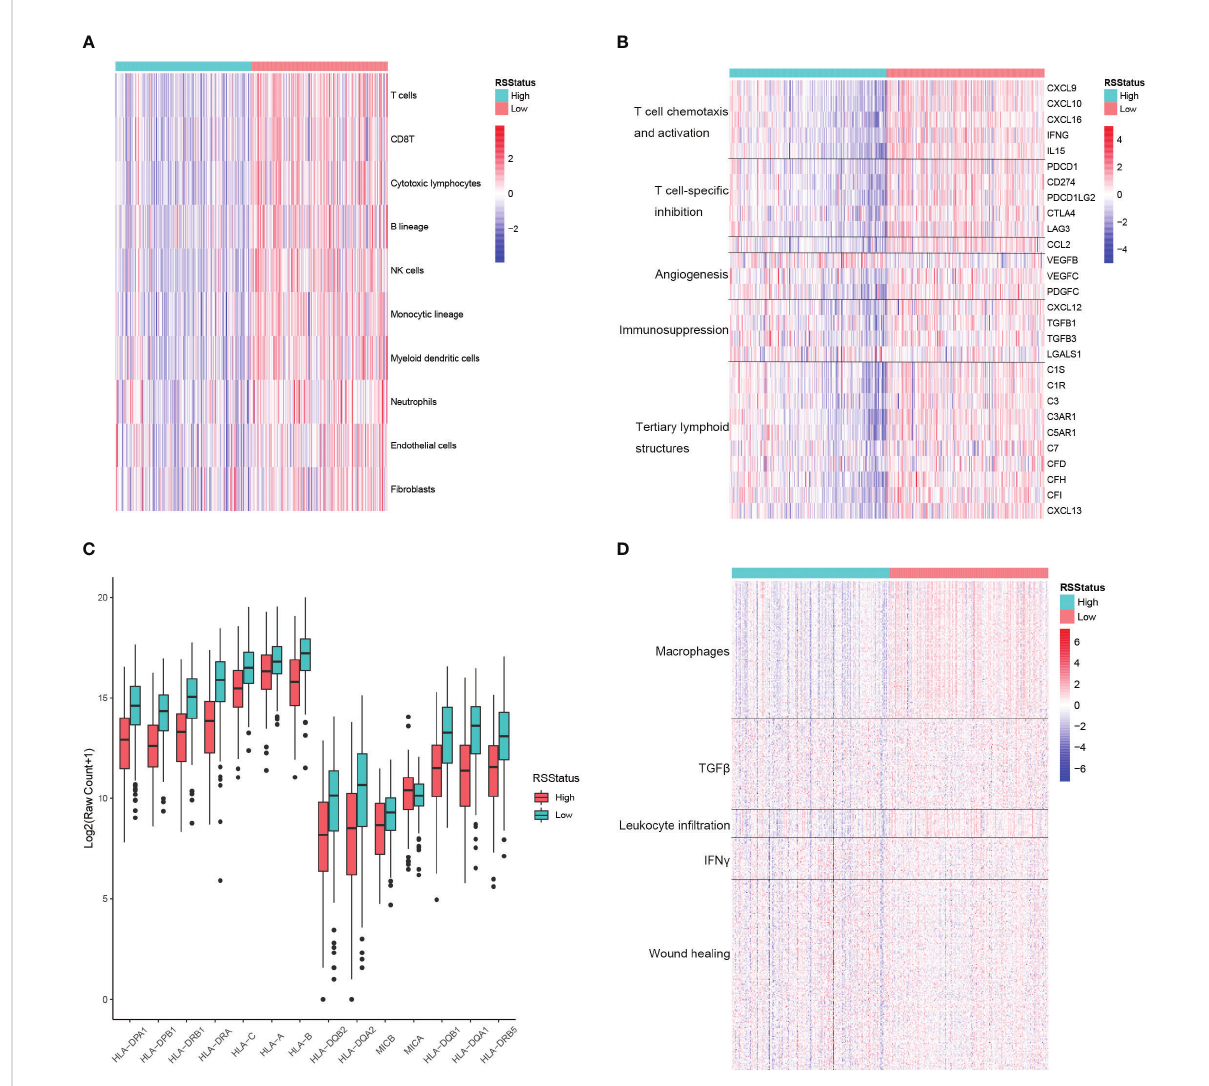
FIGURE 5 The signature based on the CEBPB-regulated genes in macrophages is closely associated with immune activity in metastatic SKCM TME. (A) Relative abundance of lymphocytes, myeloid cells, and stromal cells in metastatic SKCM patients ’ tumor samples of the TCGA-SKCM cohort strati fi ed by the median RS value. (B) Relative expression of genes of several immunologically suppressive and active signatures in metastatic SKCM patients ’ tumor samples of the TCGA-SKCM cohort strati fi ed by the median RS value. (C) Relative expression of antigen presentation- related genes in metastatic SKCM patients ’ tumor samples of the TCGA-SKCM cohort with higher and lower RS strati fi ed by the median RS value. Asterisk indicates a signi fi cant difference, namely, p-value< 0.05. n.s. represents non-signi fi cance. (D) Relative expression of genes used for de fi ning immune cluster in the study of Shmulevich et al. (34) in the metastatic SKCM patients ’ tumor tissues of the TCGA-SKCM cohort strati fi ed by the median RS value. RSStatus, risk score status based on the median RS value; SKCM, skin cutaneous melanoma; TME, tumor